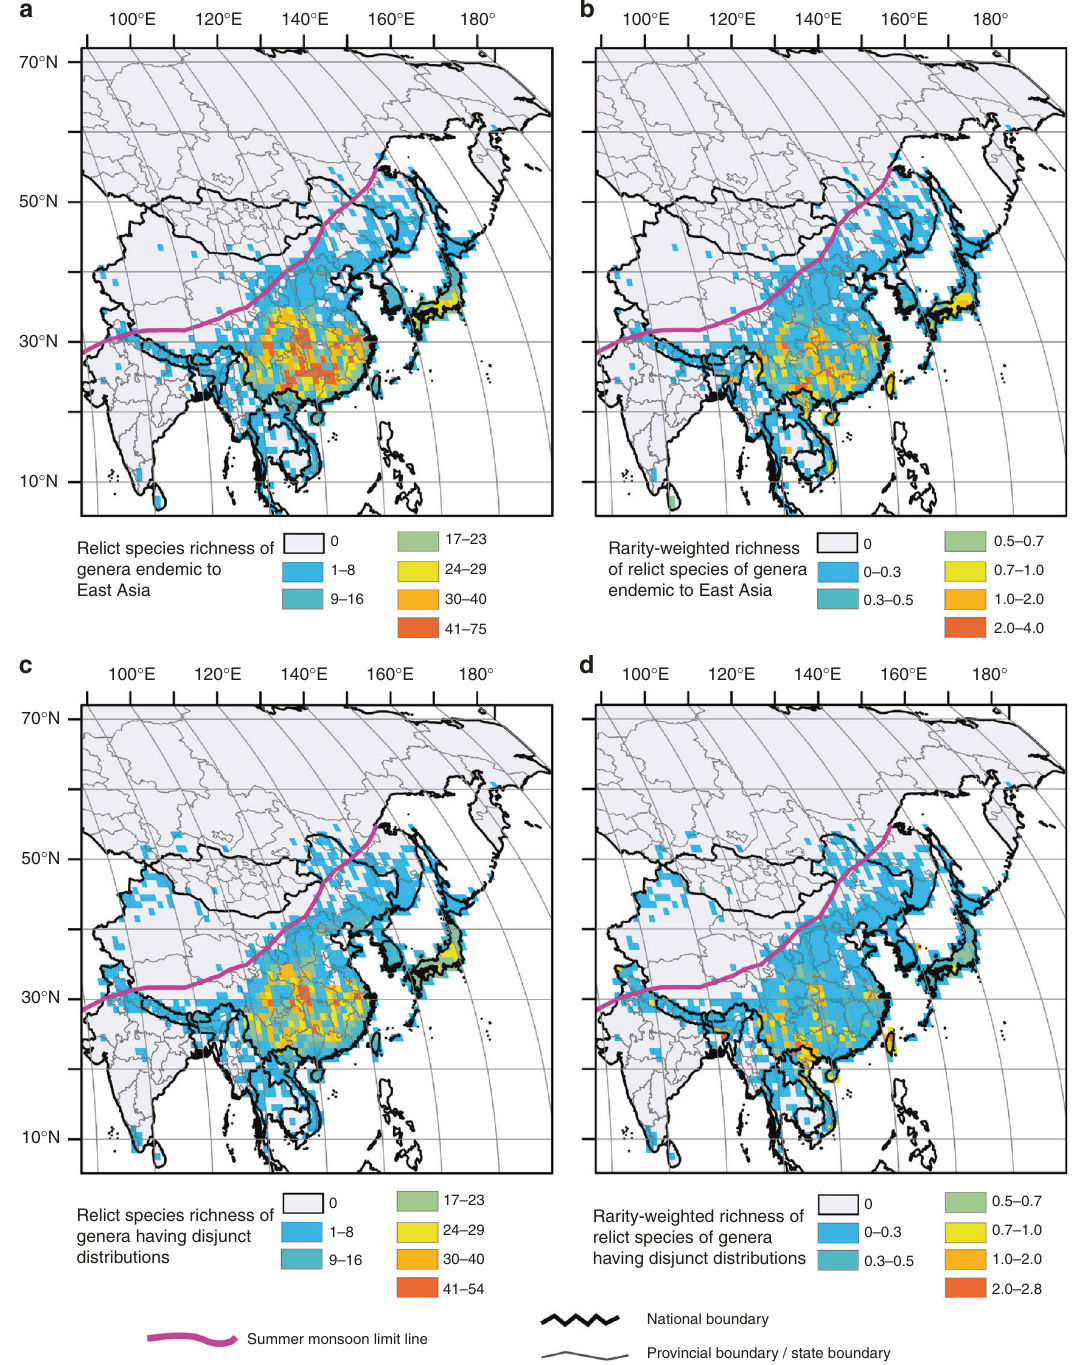
Fig. 1 Relict species richness and rarity-weighted richness. a Relict species richness of genera endemic to East Asia. b Rarity-weighted richness of relict species of genera endemic to East Asia. c Relict species richness of genera having disjunct distributions between East Asia and other parts of the world. d Rarity-weighted richness of relict species of genera having disjunct distributions between East Asia and other parts of the world. The summer monsoon limit line adapted from Chen et al. 79 , showing the approximate limit of modern summer monsoon precipitation. For the national boundary between China and India, please see Supplementary Fig. 2A and Methods. Maps were generated using the software ArcGIS v. 10.5 (ESRI, Redlands, CA, USA) and modi fi ed using Canvas 12 (ACD Systems of America, Inc., Seattle, WA, USA). Map layers were obtained from site